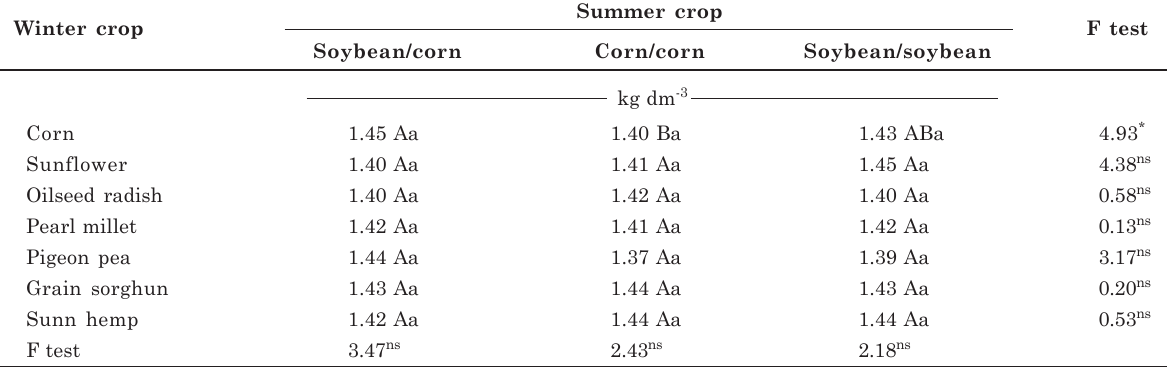
Values followed by the same letter, lowercase letters in the columns and uppercase letters in the lines, are not significantly different by the Tukey test (p<0.05). * p<0.05, ns not